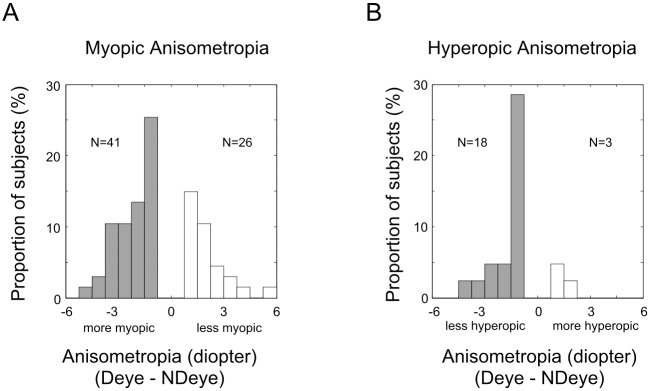
Dominant eyes were more myopic in myopic anisometropic subjects (A) and less hyperopic in hyperopic anisometropic subjects (B).The amplitude of anisometropia was calculated as the refractive error of the dominant eye minus the refractive error of the non-dominant eye.